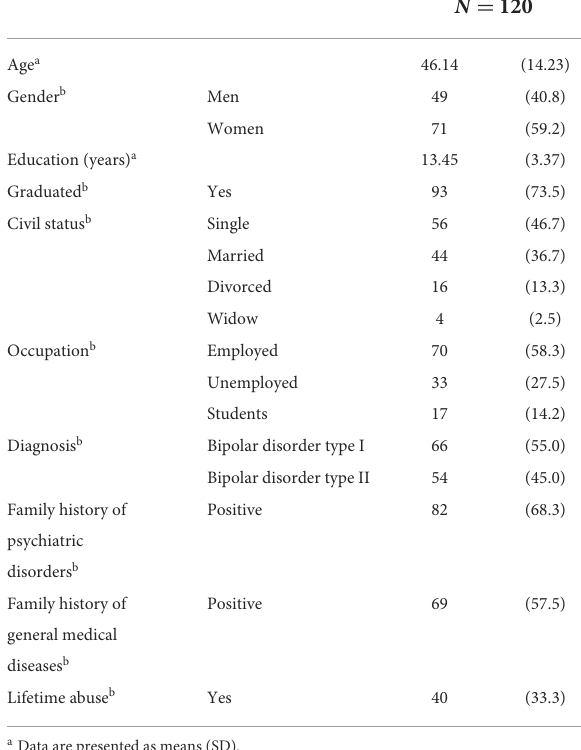
TABLE 1 Demographics and personal characteristics of the